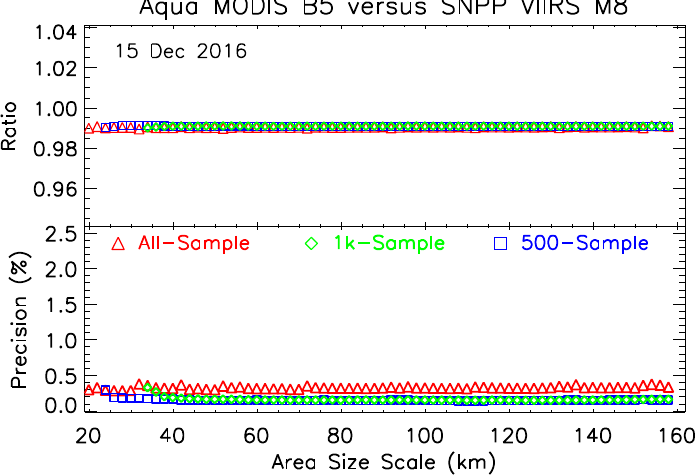
Figure 5. The ratio (top) and the relative precision (bottom) versus area size for the three cases of unconstrained sample size (red stars), constrained size at 1000 samples (blue squares), and constrained size at 500 samples (green diamonds) for the clear-scene SNO event on 15 December 2016 for Aqua MODIS M8 versus SNPP VIIRS